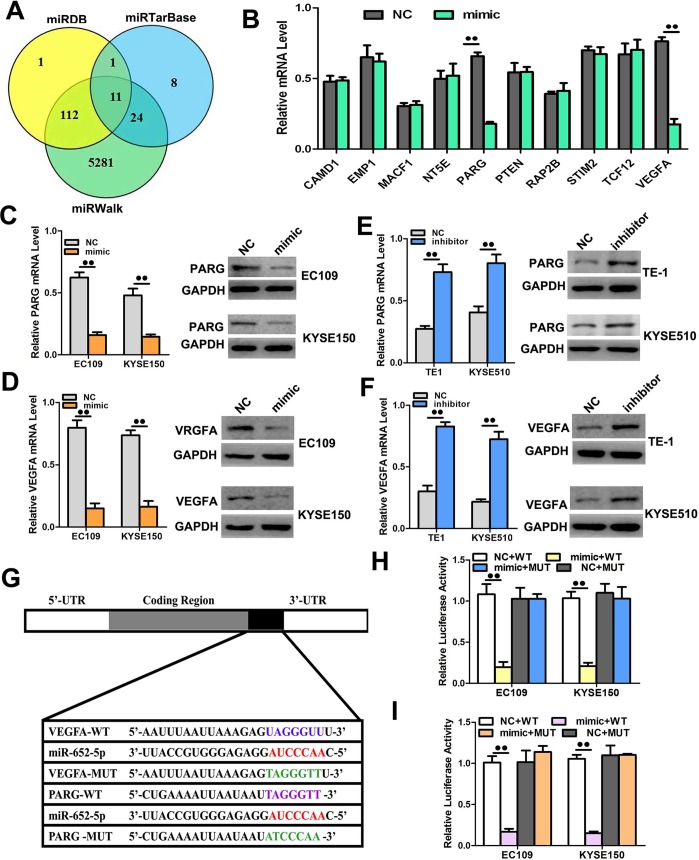
PARG and VEGFA are the direct targets of miR-652-5p.(A-B)PARG and VEGFA were predicted and verified as the targets of miR-652-5p. (C-D) The expressions of PARG and VEGFA in EC109 and KYSE150 cells transfected with miR-652-5p mimic were measured by qRT-PCR and western blot. (E-F) The mRNA and protein expressions of PARG and VEGFA in EC109 and KYSE150 cells transfected with miR-652-5p inhibitor were measured by qRT-PCR and western blot, respectively. (G-I) The luciferase activities in OSCC cells were detected after the co-transfection of miR-652-5p mimic and vectors containing WT or MUT 3’-UTR of PARG and VEGFA. Data from triplicate experiments are presented.